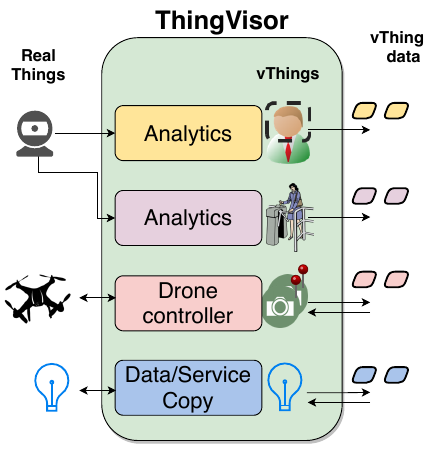
Figure 6. ThingVisor and